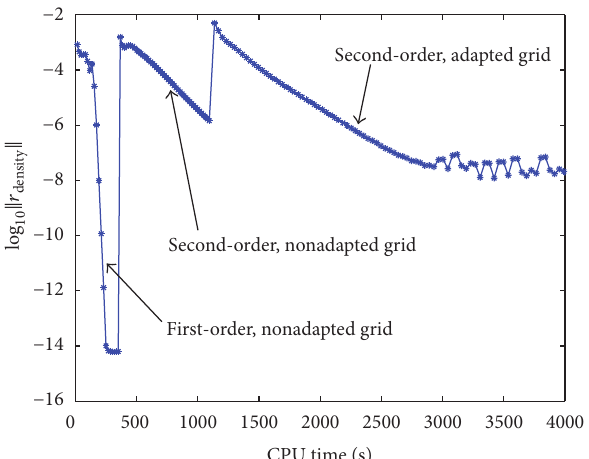
F 12: ONERA M6 wing. Convergence history of the of the (Euclidean) norm of the density